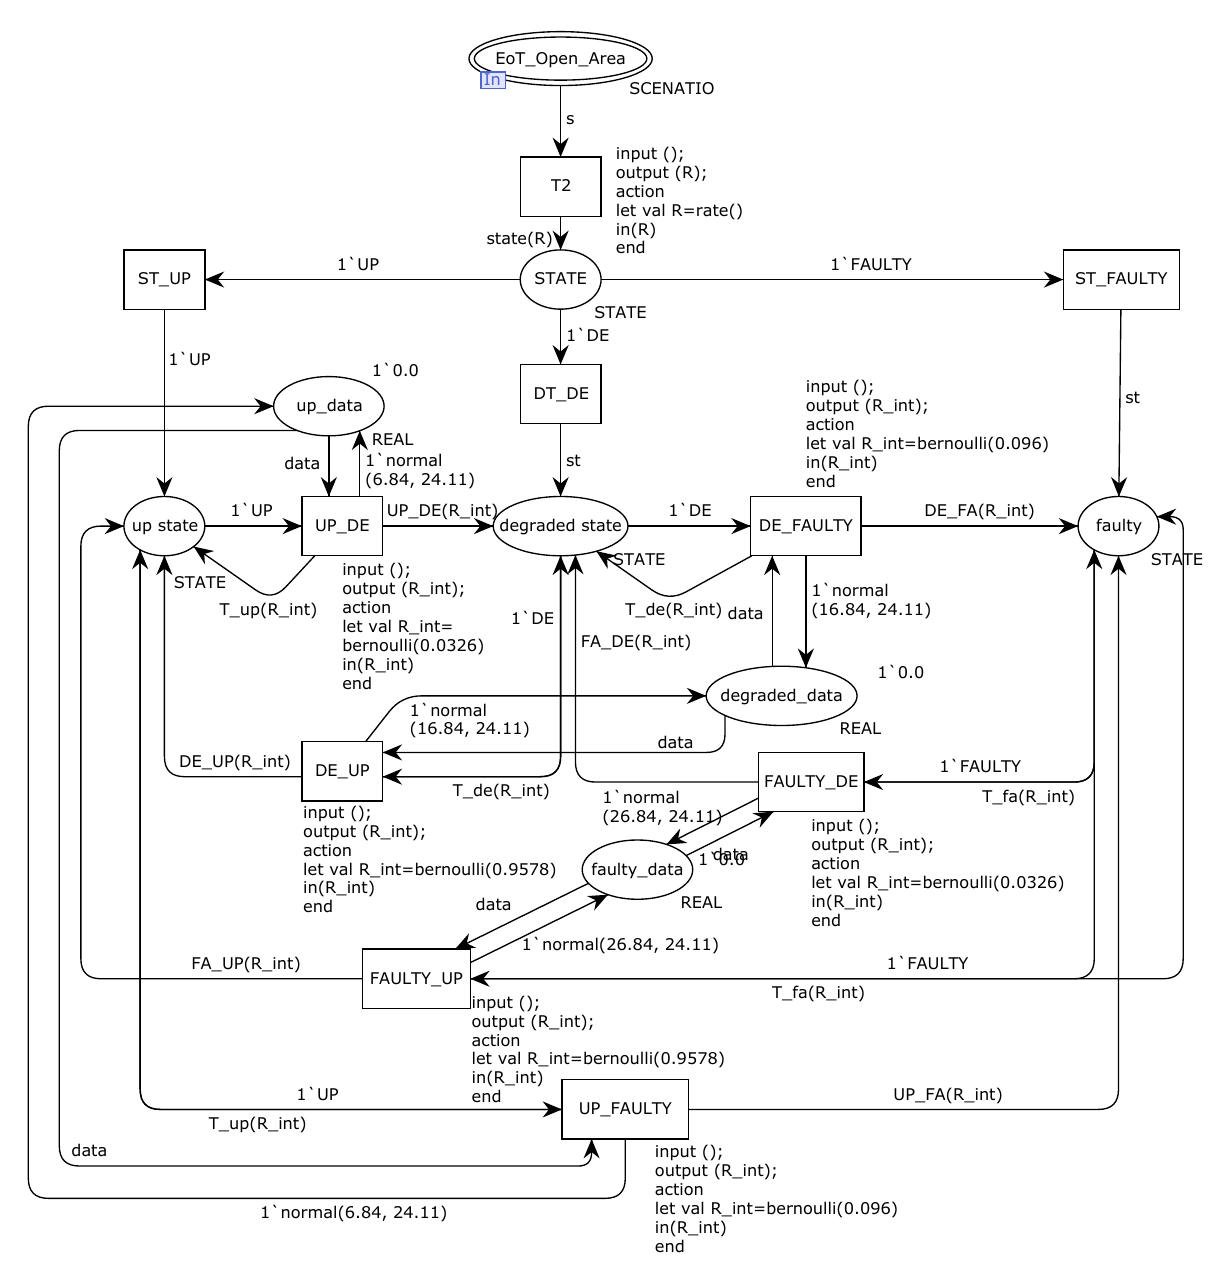
Figure 11. Second layer CPN model of scenario in detail.